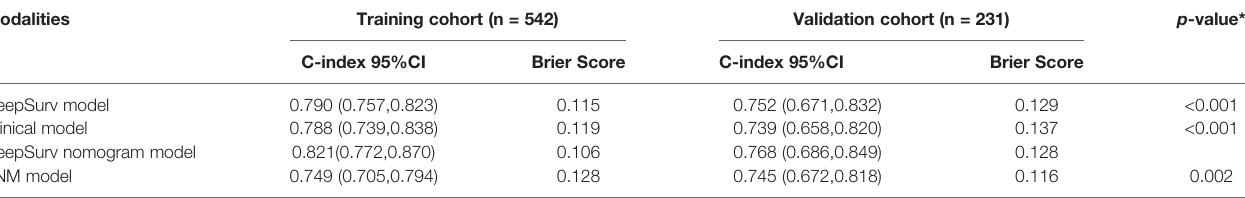
TABLE 3 | Harrell ’ s concordance index of the different modalities.